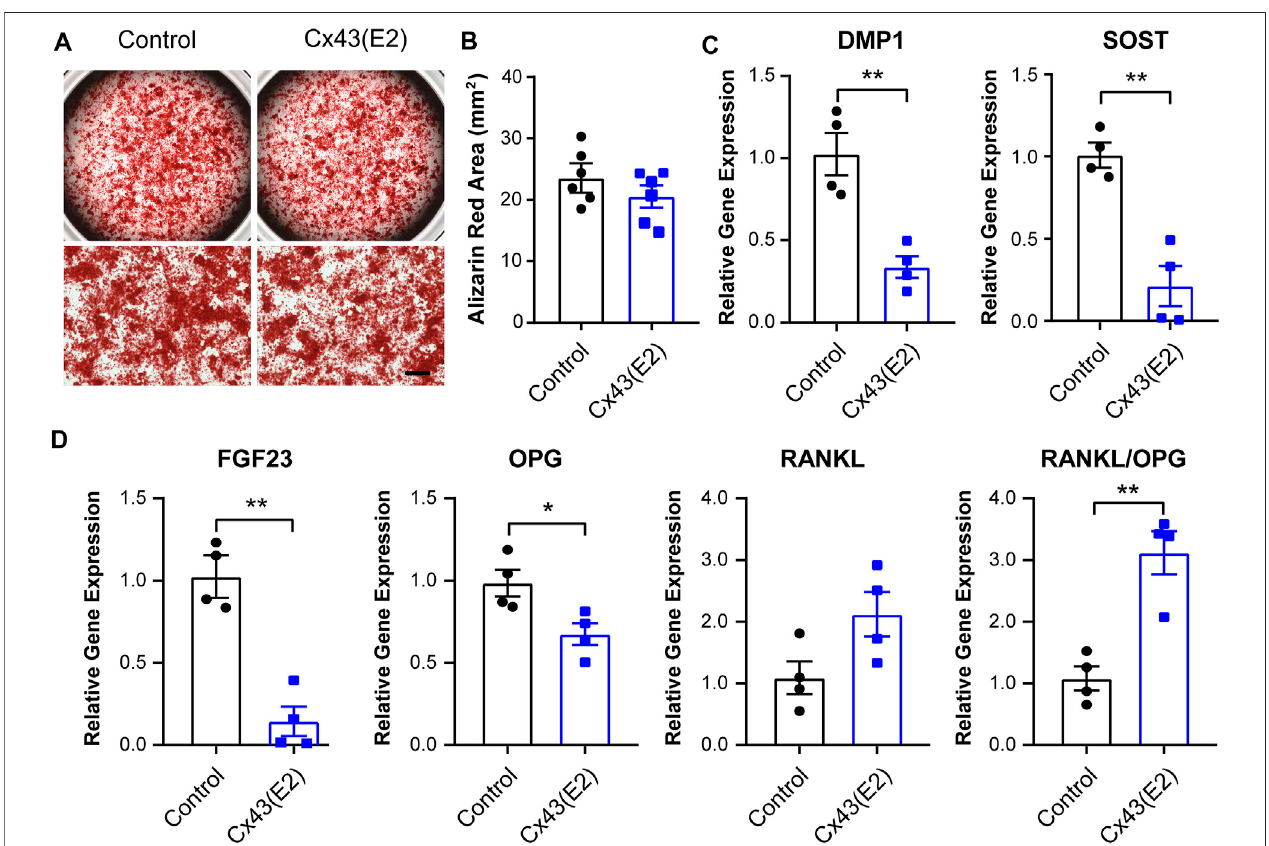
FIGURE 7 | Inhibition of Cx43 hemichannels decreased osteocytic markers expression in IDG-SW3 cells. (A) Representative images of Alizarin red staining in controlorCx43(E2)antibody – treatedIDG-SW3cellsatday28oftheinductionofdifferentiation.Lowerpanelsshowenlargedviewofthecenterregionsofupperpanels. Scale bar, 500 μ m. (B) Quanti fi cation of Alizarin red – stained area by NIH ImageJ software. (C – D) Total RNA was prepared from control or Cx43 (E2) antibody – treated IDG-SW3 cells after 28 days of differentiation. The mRNA levels of DMP1, SOST, FGF23, OPG, and RANKL were determined by real-time PCR normalized to GAPDH. Data shown are mean ± SEM. *, p < 0.05, **, p < 0.01.